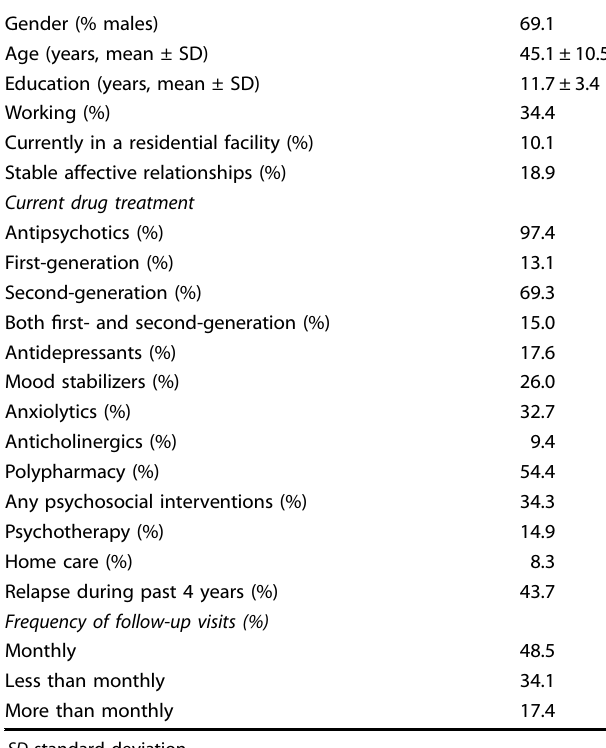
Table 1. Socio-demographic and clinical variables of the study